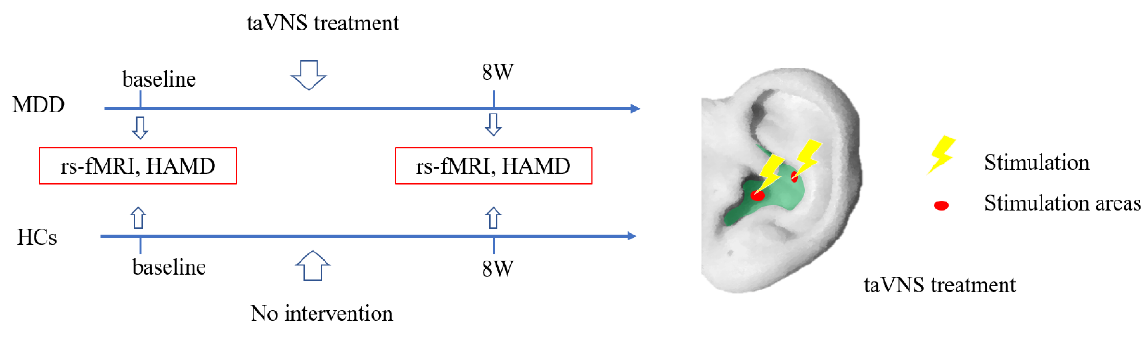
Figure 1. Test flowchart and schematic diagram of taVNS treatment. 8W, 8 weeks; rs-fMRI, resting- state functional MRI; HAMD, Hamilton Depression Scale. Light-green, shaded area represents the auricular concha.